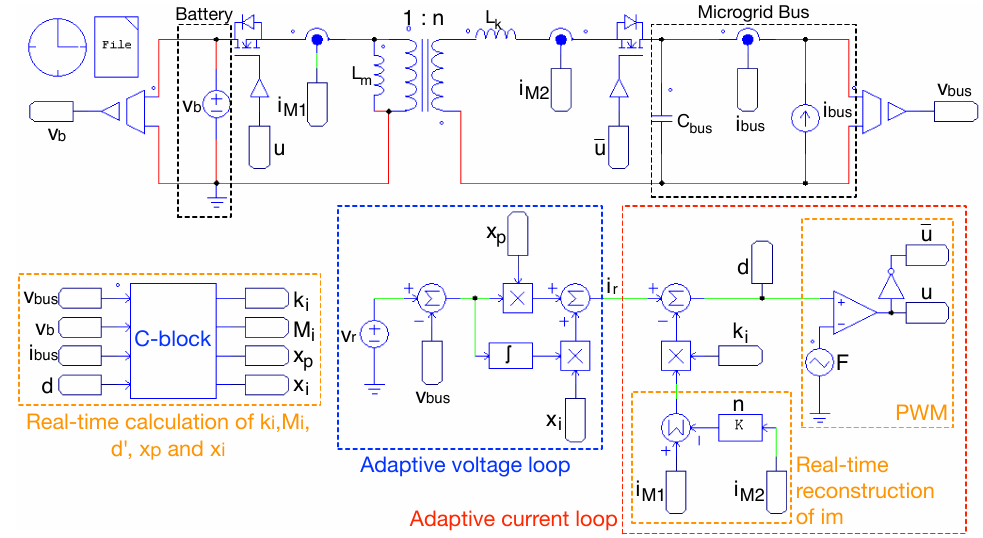
Figure 6. Circuital implementation in PSIM of both power and control systems.